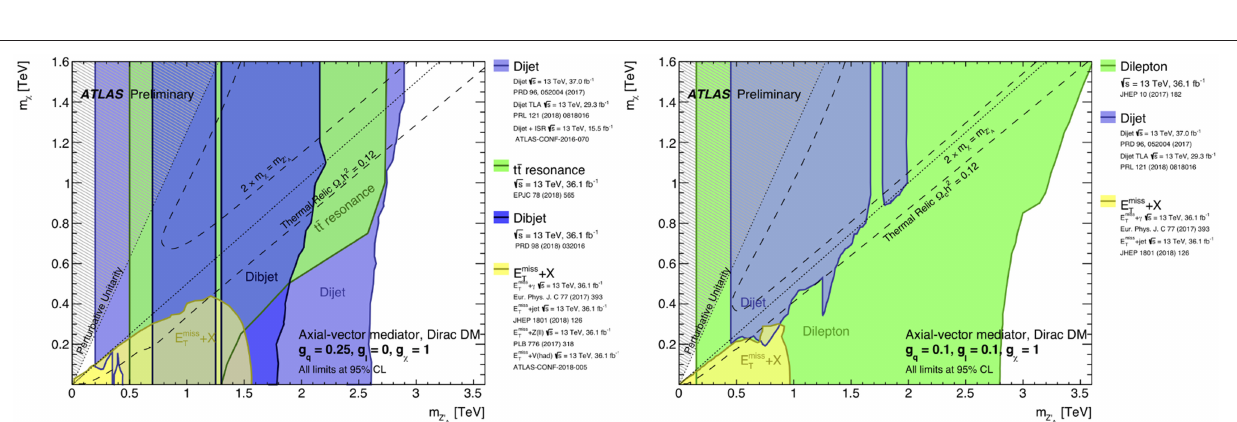
Frontiers in Physics |